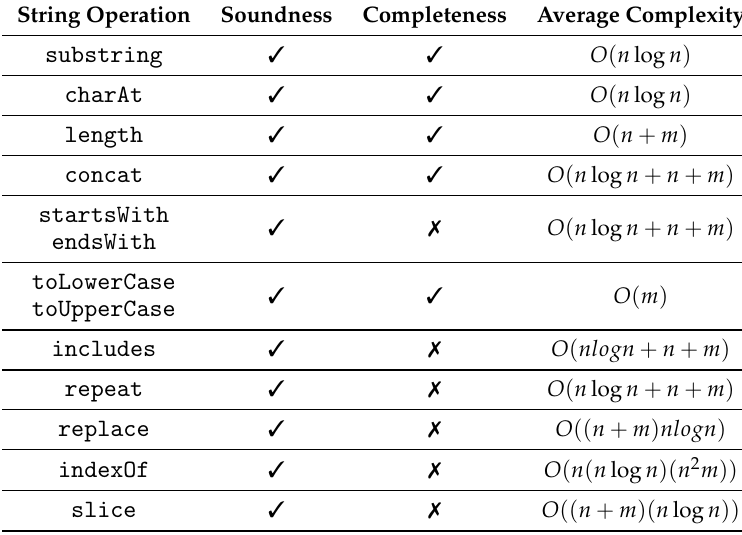
Table 2. µ JS Finite-state Automata String Analyzer ( µ F ASA ) string